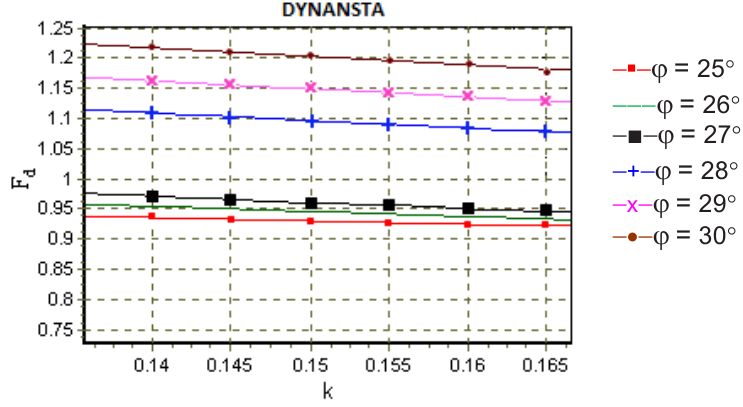
Figure 3: Effect of the internal friction angle.